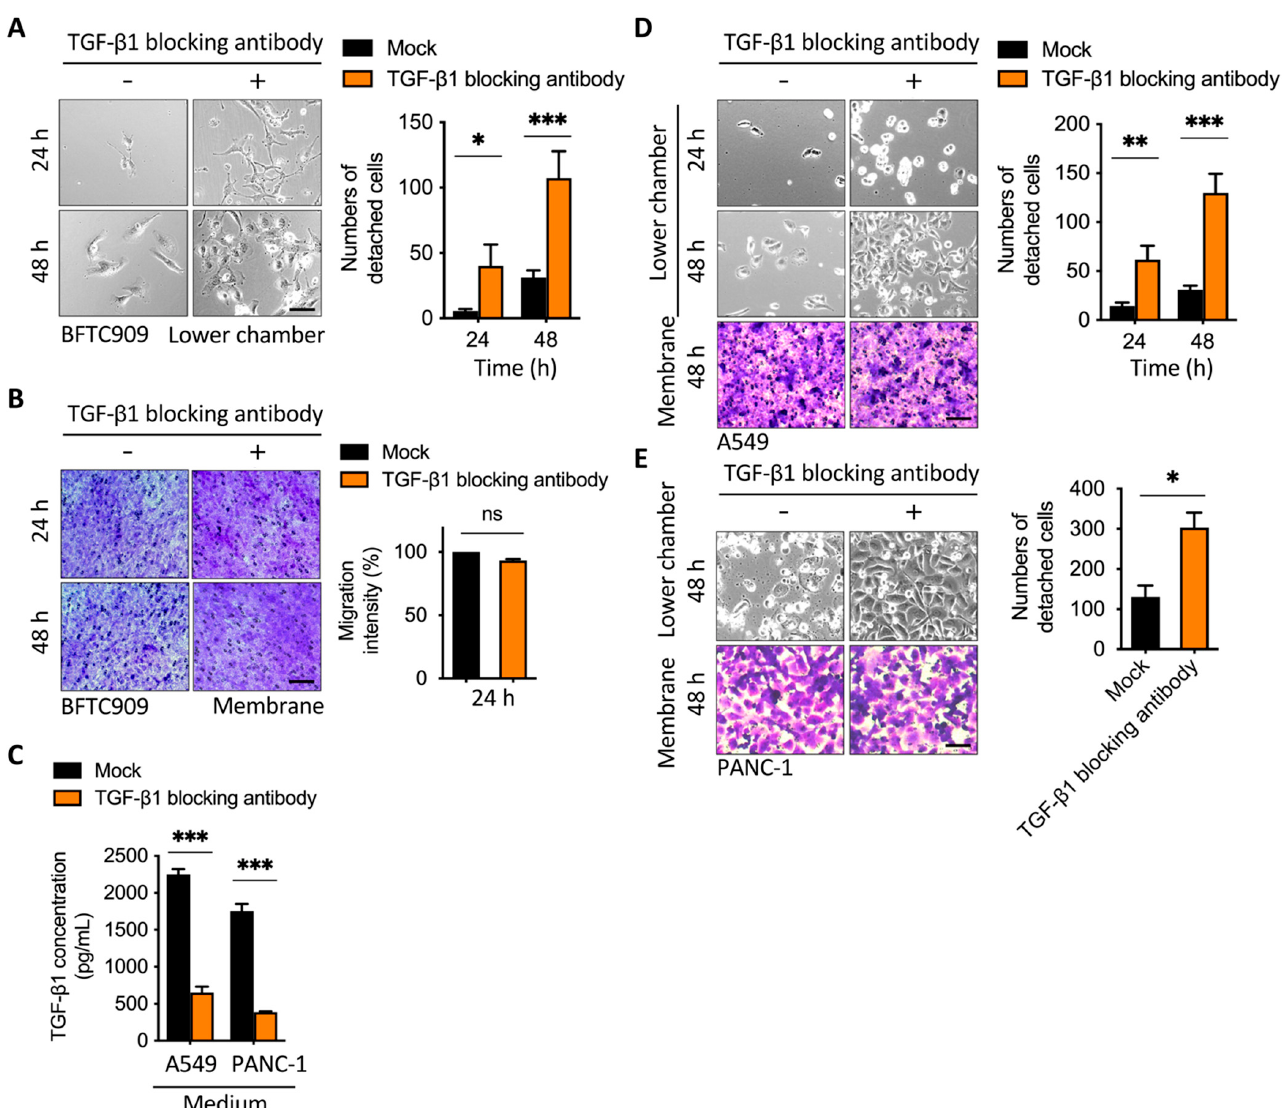
Figure 2. Blockage of TGF- β 1 increased cell detachment after transmembrane migration. ( A ) Representative images of lower chamber and ( B ) transwell membrane demonstrated that the treatment of cancer cells with TGF- β 1-blocking antibody increased detachment in the leading cells. BFTC909 cells were seeded in the upper chamber overnight and the transwell assay was performed with or without TGF- β 1-blocking antibody in the lower chamber for 48 h. The membranes were stained by crystal violet and the cell number from membranes or the lower chamber was counted. Scale bars: 100 µ m. * p < 0.05; *** p < 0.001. Data are means ± s.d. (two-way ANOVA with Tukey’s multiple comparisons test and two-tailed t -test, A , B , respectively) from experiments with three replicates ( n = 3). ns, not significant. ( C ) ELISA assay showing treatment of TGF- β 1-blocking antibody reduced TGF- β 1 from the medium of the lower chamber. *** p < 0.001. Data are means ± s.d. (two-tailed t -test) from experiments with three replicates ( n = 3). ( D , E ) Representative images of lower chamber and transwell membrane demonstrated that the treatment of A549 and PANC-1 cells with TGF- β 1-blocking antibody increased detachment in the leading cells. Scale bars: 100 μ m. (* p < 0.05; ** p < 0.01; *** p < 0.001). Data are means ± s.d. (two-way ANOVA with Tukey’s multiple comparisons test and two-tailed t-test, D and E, respectively) from experiments with three replicates ( n = 3). Mock, mouse IgG1.